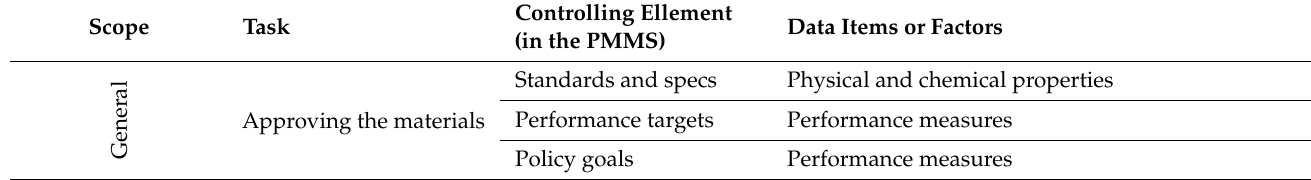
Table 2. Key components of the material selection process in a